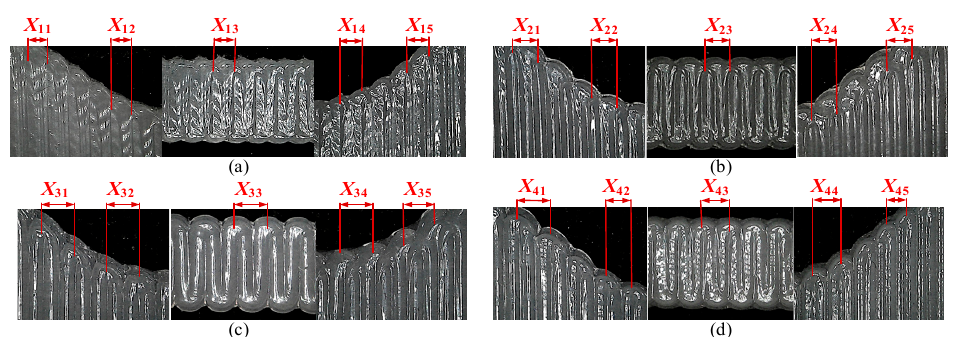
Figure 5. Detail of the AM specimens: ( a ) X = 0.8 mm, F =2520 mm/min, P = 25 Psi; ( b ) X = 1.0 mm, F = 2100 mm/min, P = 25 Psi; ( c ) X = 1.2 mm, F = 1620 mm/min, P = 25 Psi; ( d ) SMO: X 1 = 1.2 mm, X 2 = 1.0 mm, X 3 = 0.8 mm, F 1 = 1620 mm/min, F 2 = 2100 mm/min, F 3 = 2520 mm/min, P = 25 Psi; ( e ) injection molded specimen. The spots are caused by dust.